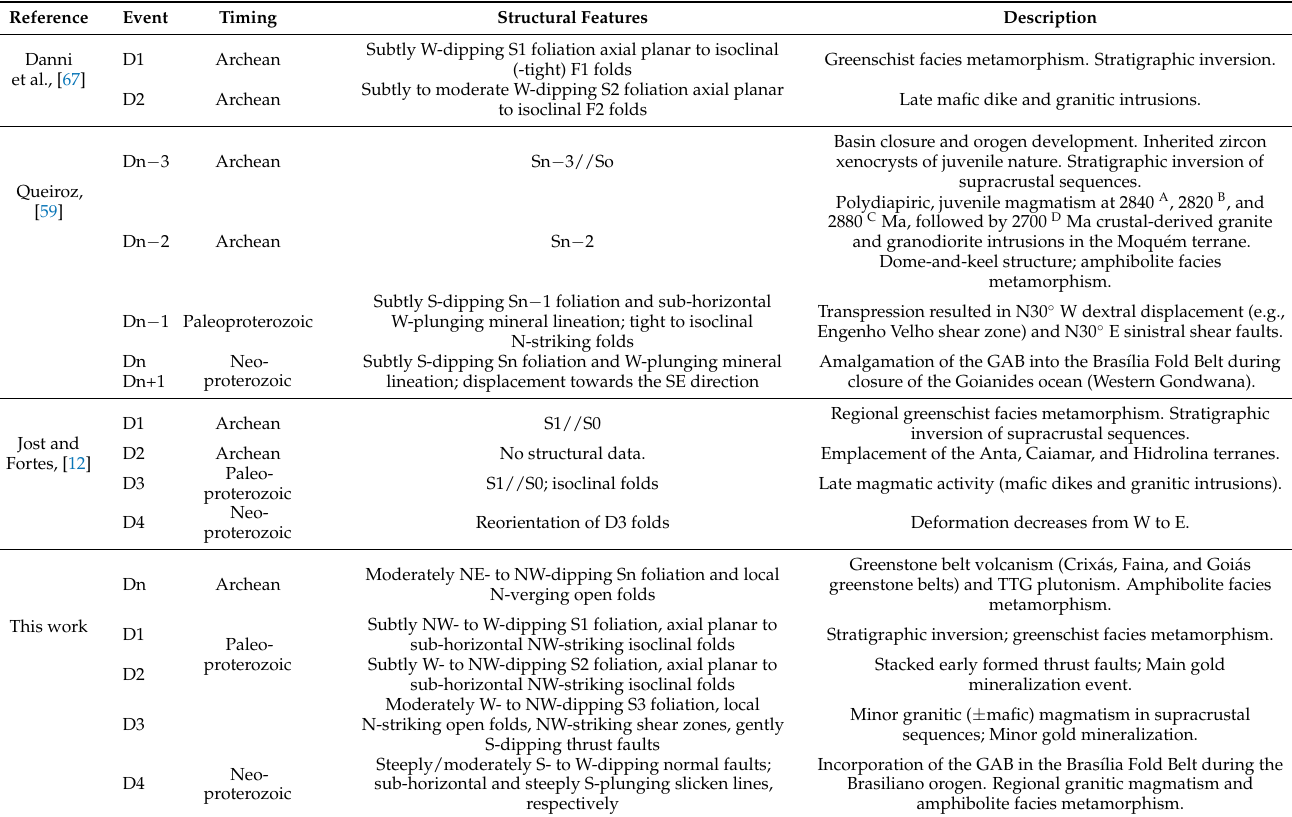
Table 2. Previous deformation history of the